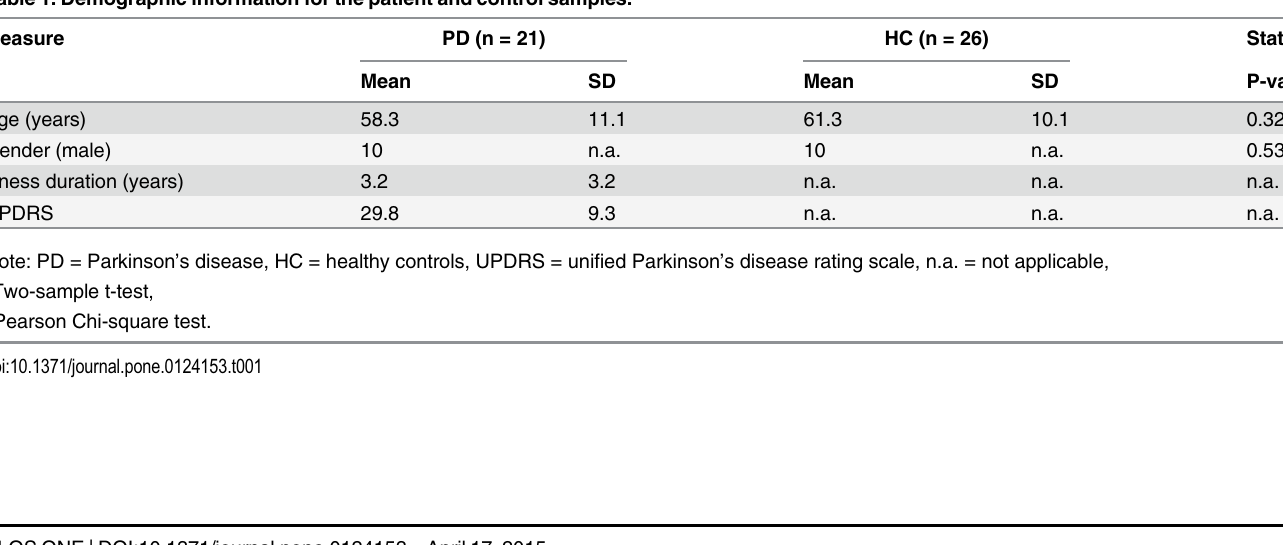
Table 1. Demographic information for the patient and control samples. Measure